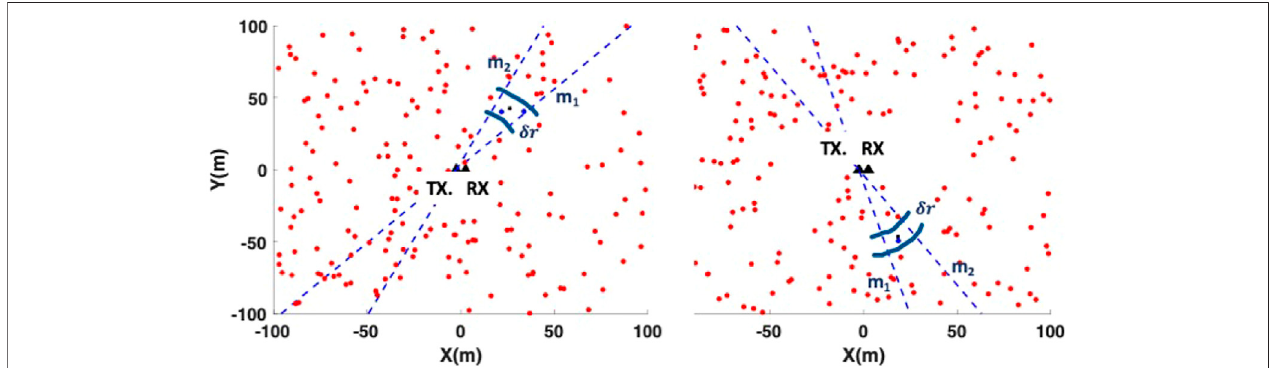
FIGURE 2 | Two realizations of Monte Carlo simulations with bistatic radar transmitter (BS) and receiver (RX) indicated by triangles. The BS is characterized by narrowbeamindicatedbydashedbluelineswithslopes m